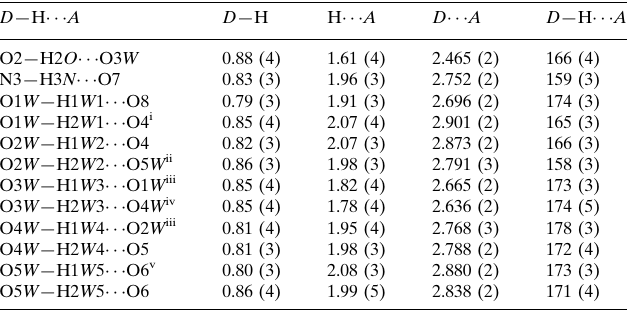
Hydrogen-bond geometry (A˚ , (cid:3)